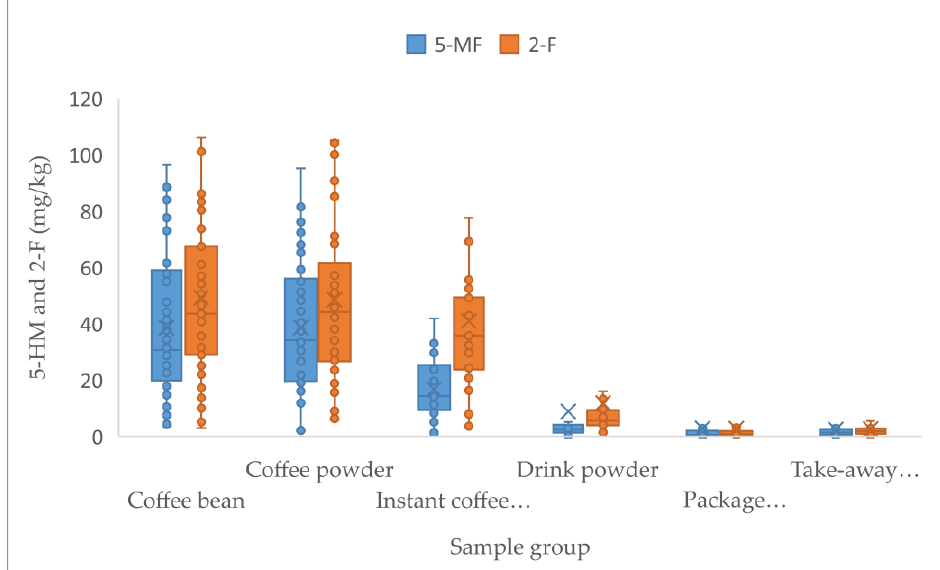
Figure 2. Box plots comparing 5-MF and 2-F concentrations in 6 coffee products in 2021. Lower and upper ends of the box represent the lower and upper quartiles (25th and 75th percentiles), the middle line represents the median, and the whiskers represent the minimum and maximum, excluding outliers.